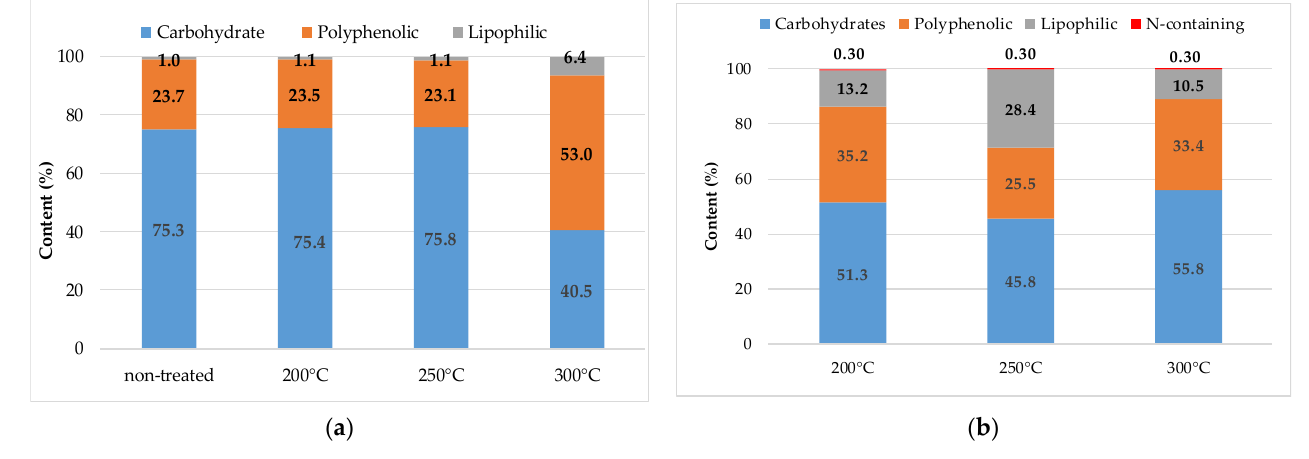
Figure 6. The relative content of carbohydrate, polyphenolic, lipophilic, and N-containing substituent-derived products in pyrolysis volatiles of non-treated and torrefied wheat straw solid fractions ( a ), and tar fractions ( b ), depending on the treatment temperature.